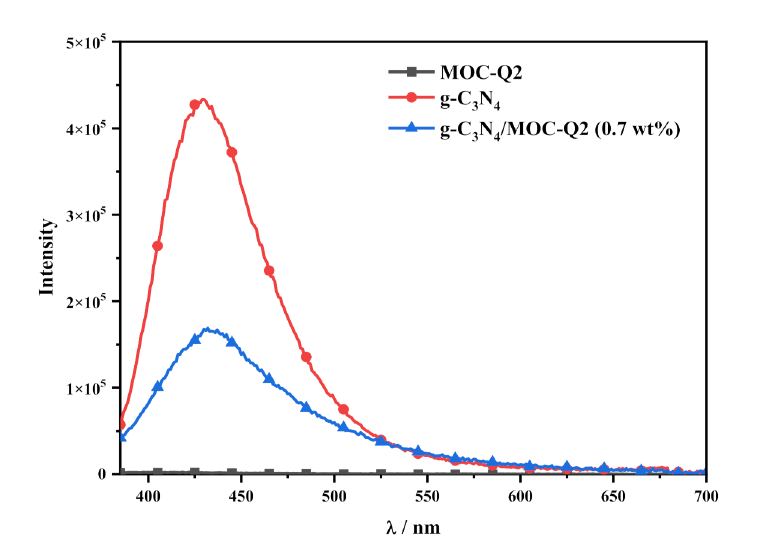
Figure 8. PL spectra of the supernatants of g-C 3 N 4 , MOC-Q2, and g-C 3 N 4 /MOC-Q2 (0.7 wt%) samples in the presence of terephthalic acid.